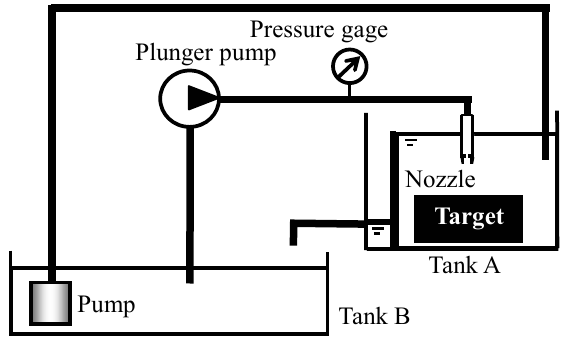
Fig. 1 Schematic diagram of cavitating jet